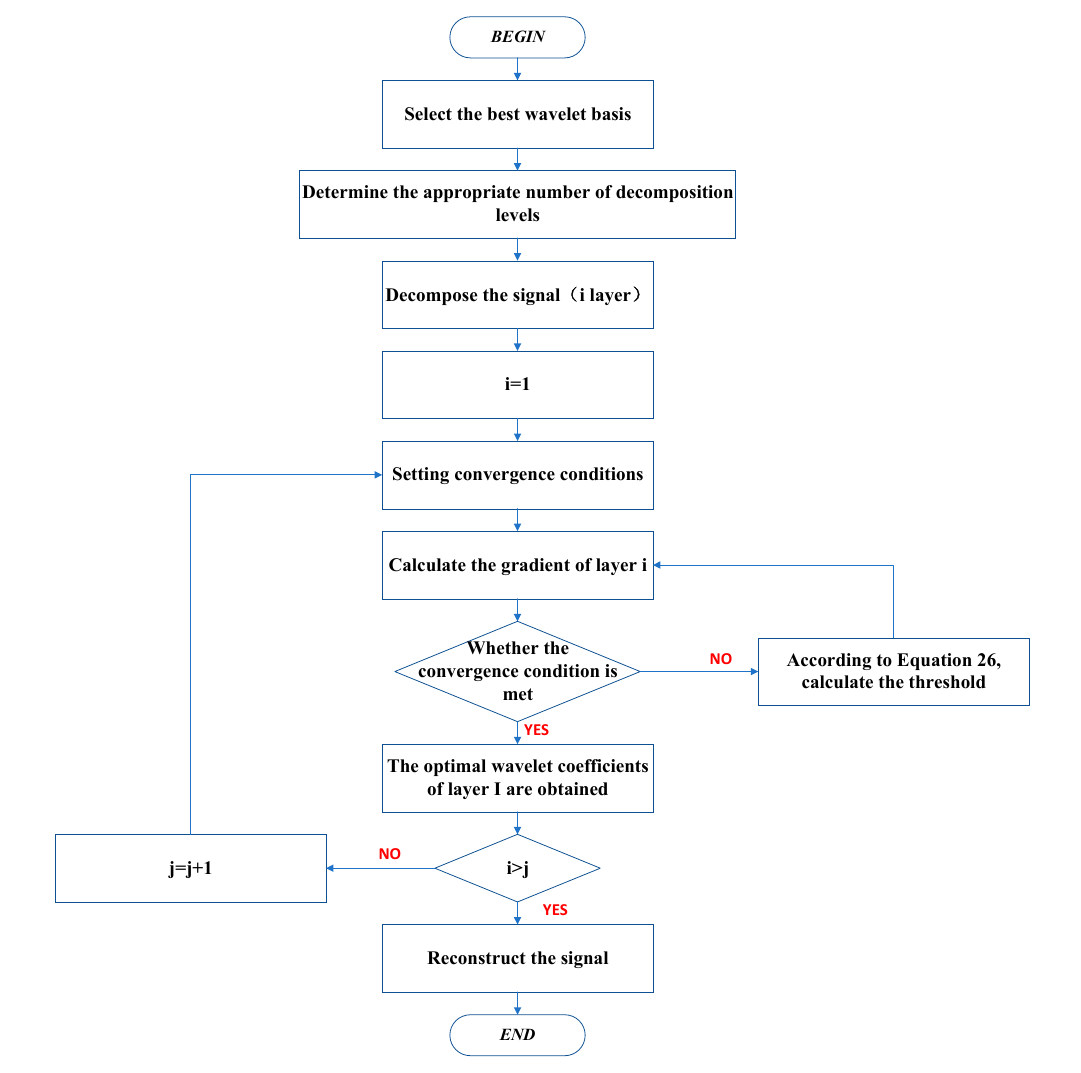
Figure 16. New wavelet threshold denoising process.